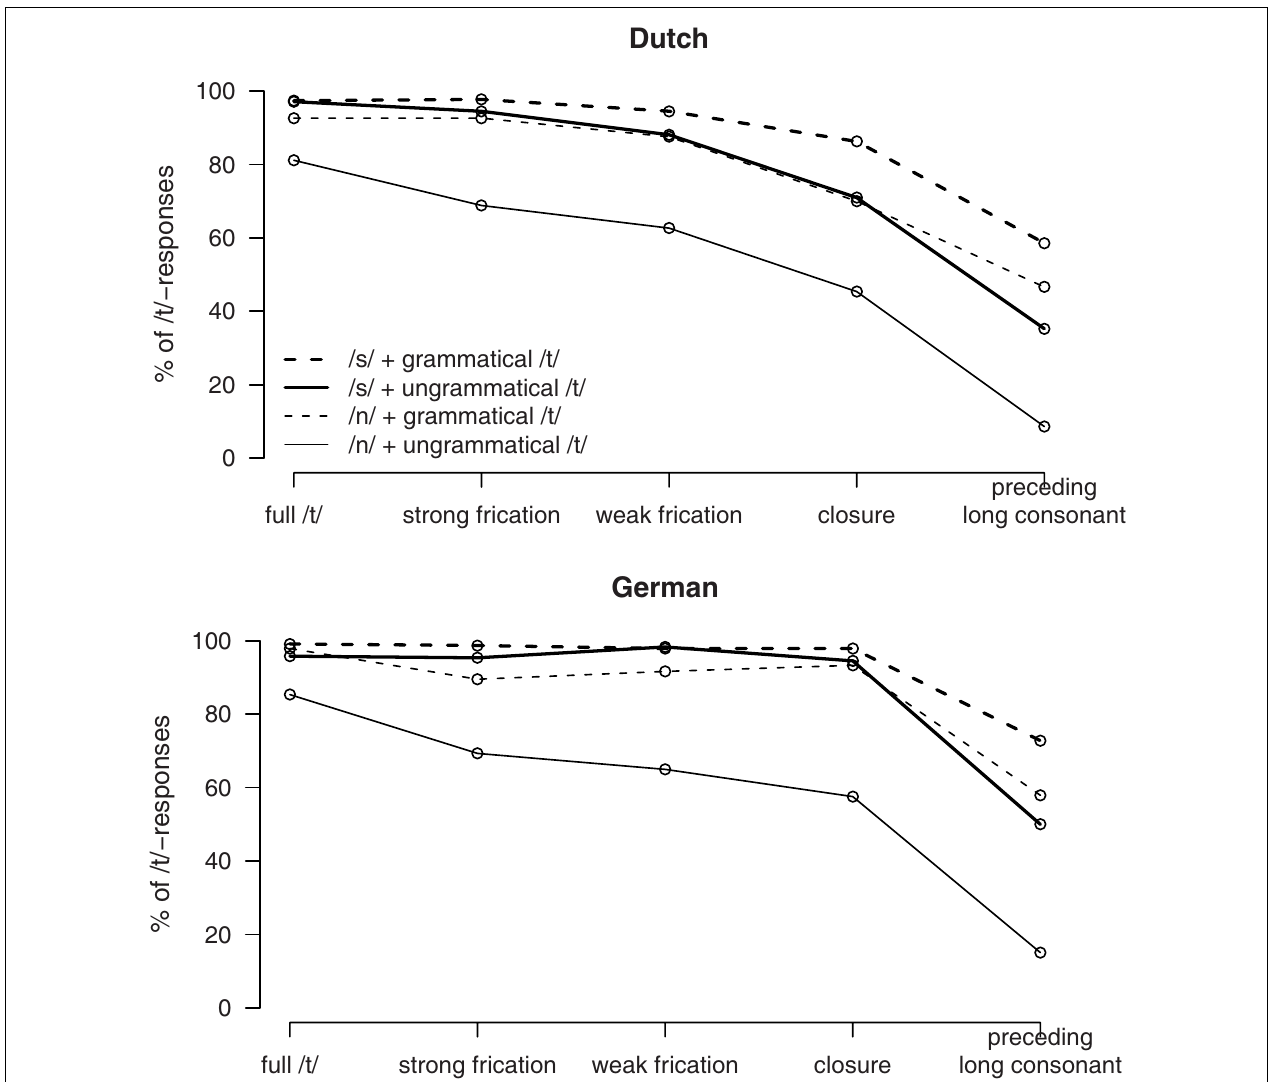
FIGURE 4 | Percentages of /t/-responses in Experiment 3 by Dutch listeners (upper panel) and German listeners (lower panel), depending on /t/-realization ( x -axis) as well as syntactic condition and phonological context (different